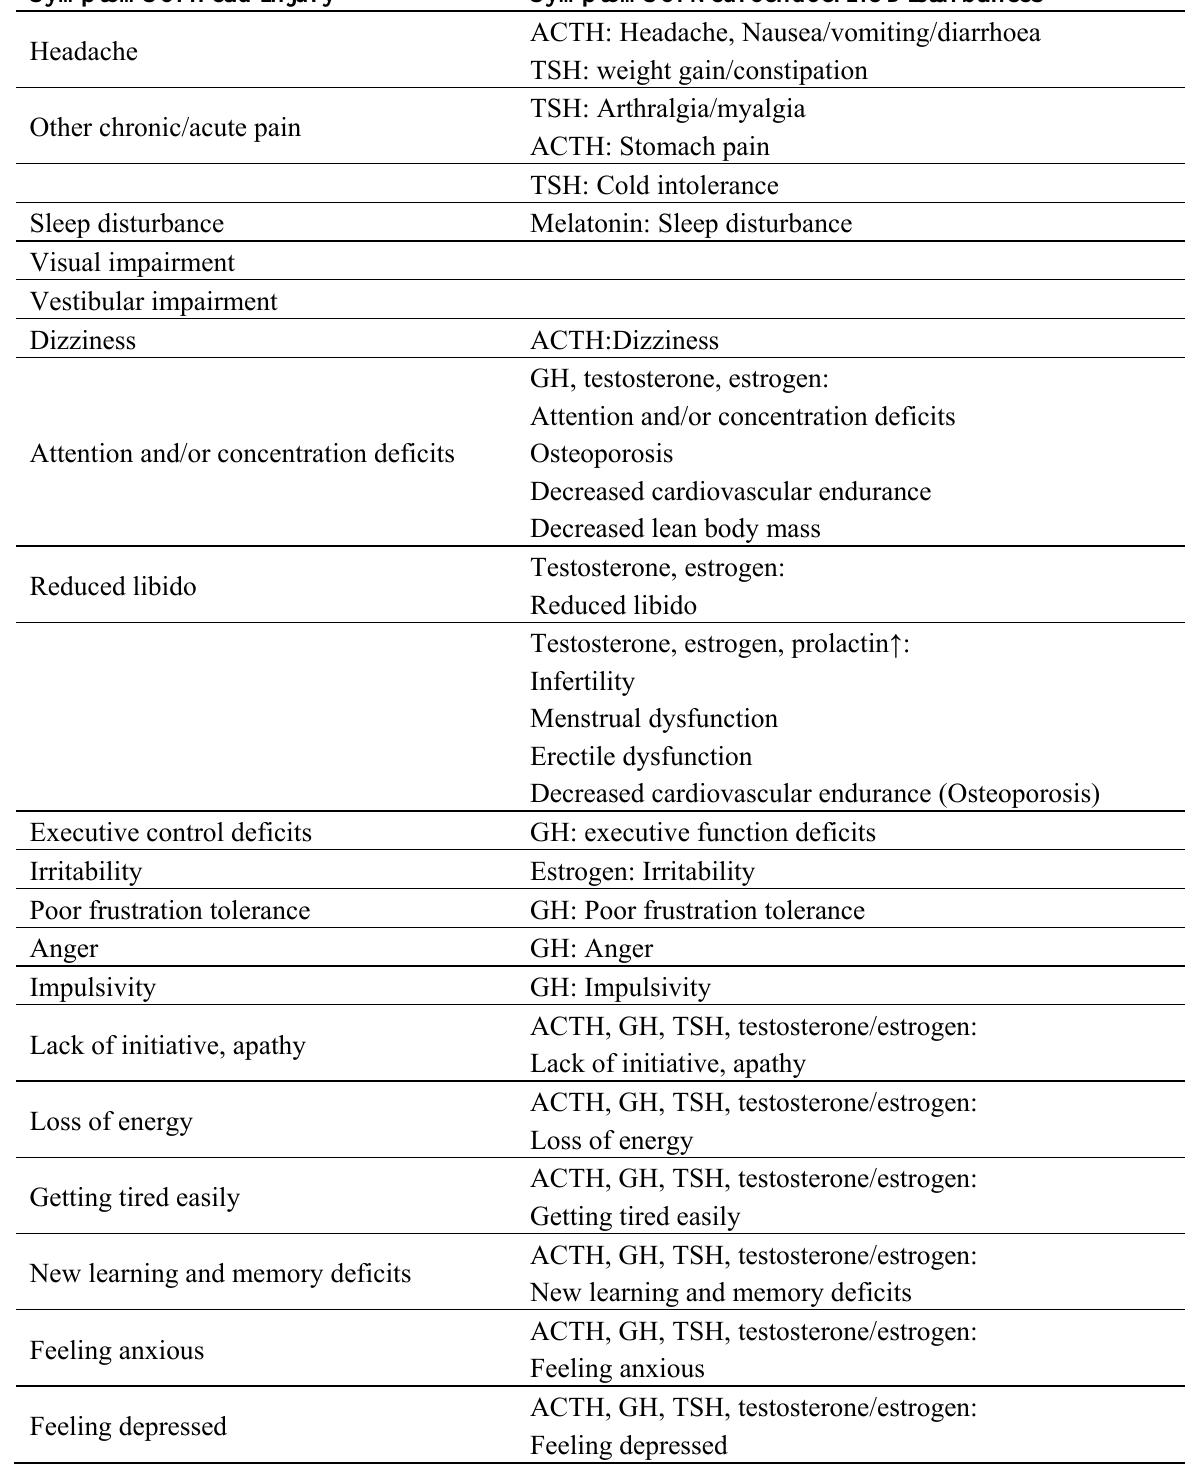
Table 2. Overlap of clinical features frequently encountered after moderate to severe head injury with those following neuroendocrine disturbances ( i.e. , anterior